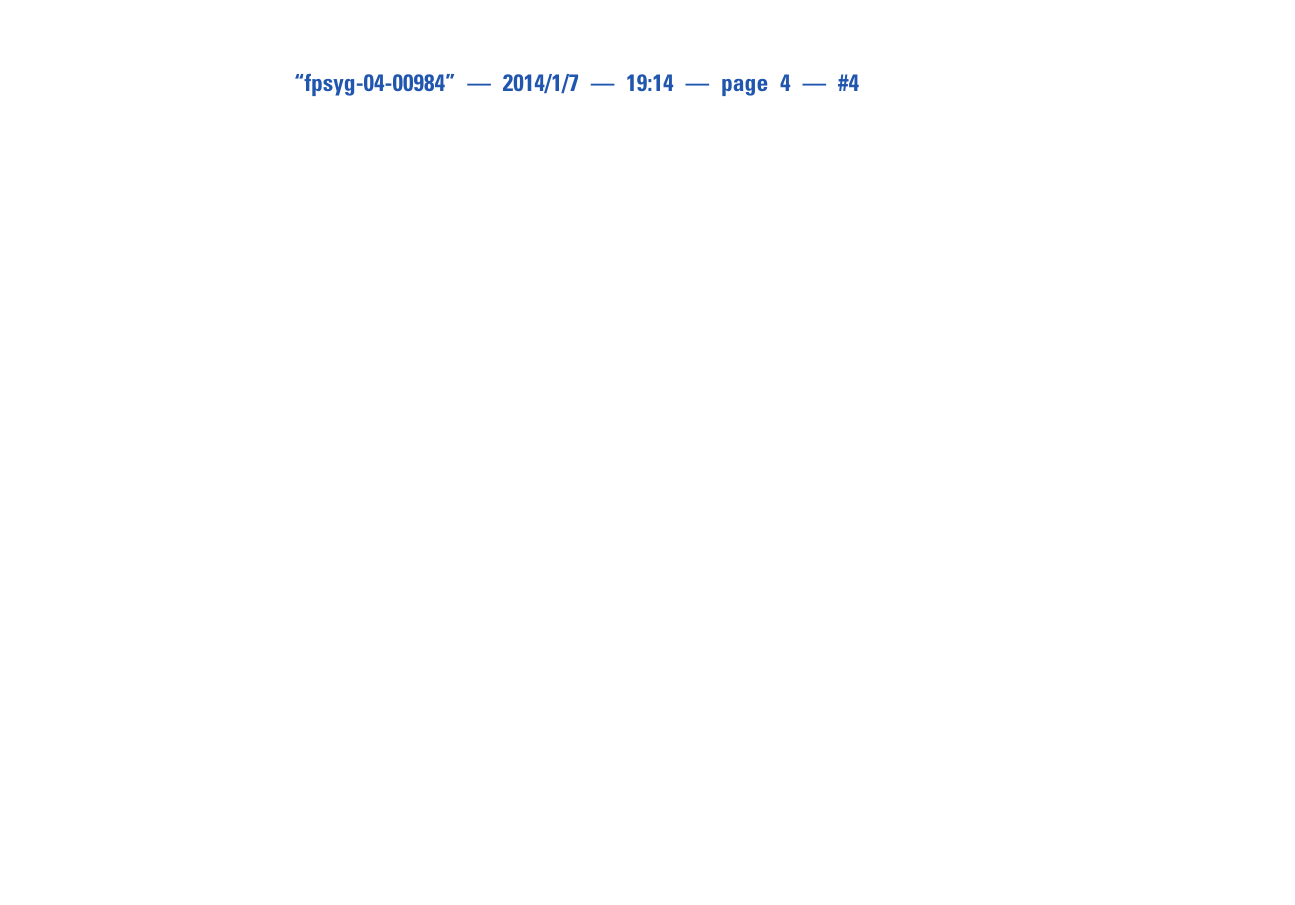
similar performance on auditory-perceptual tasks (e.g., pitch discrimination) but the groups diverge when considering more general cognitive dimensions (e.g., visuospatial WM). These data illustrate that while music-language transfer effects are bidirectional (both benefit one another), the magnitude of transfer is smaller in the language-to-music direction. * p < 0.05, ** p < 0.01, *** p <